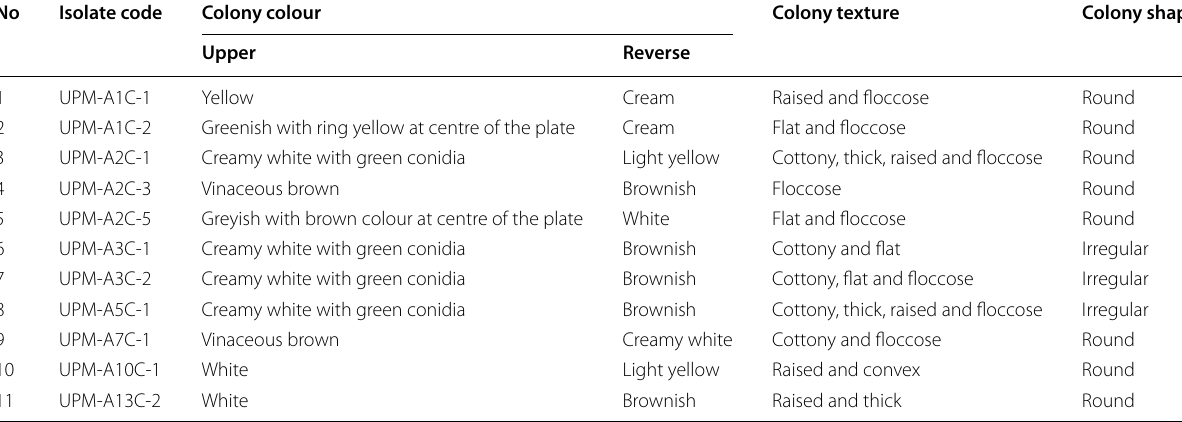
Table 2 Cultural characteristics of the EPF isolated from oil palm plantation in UPM